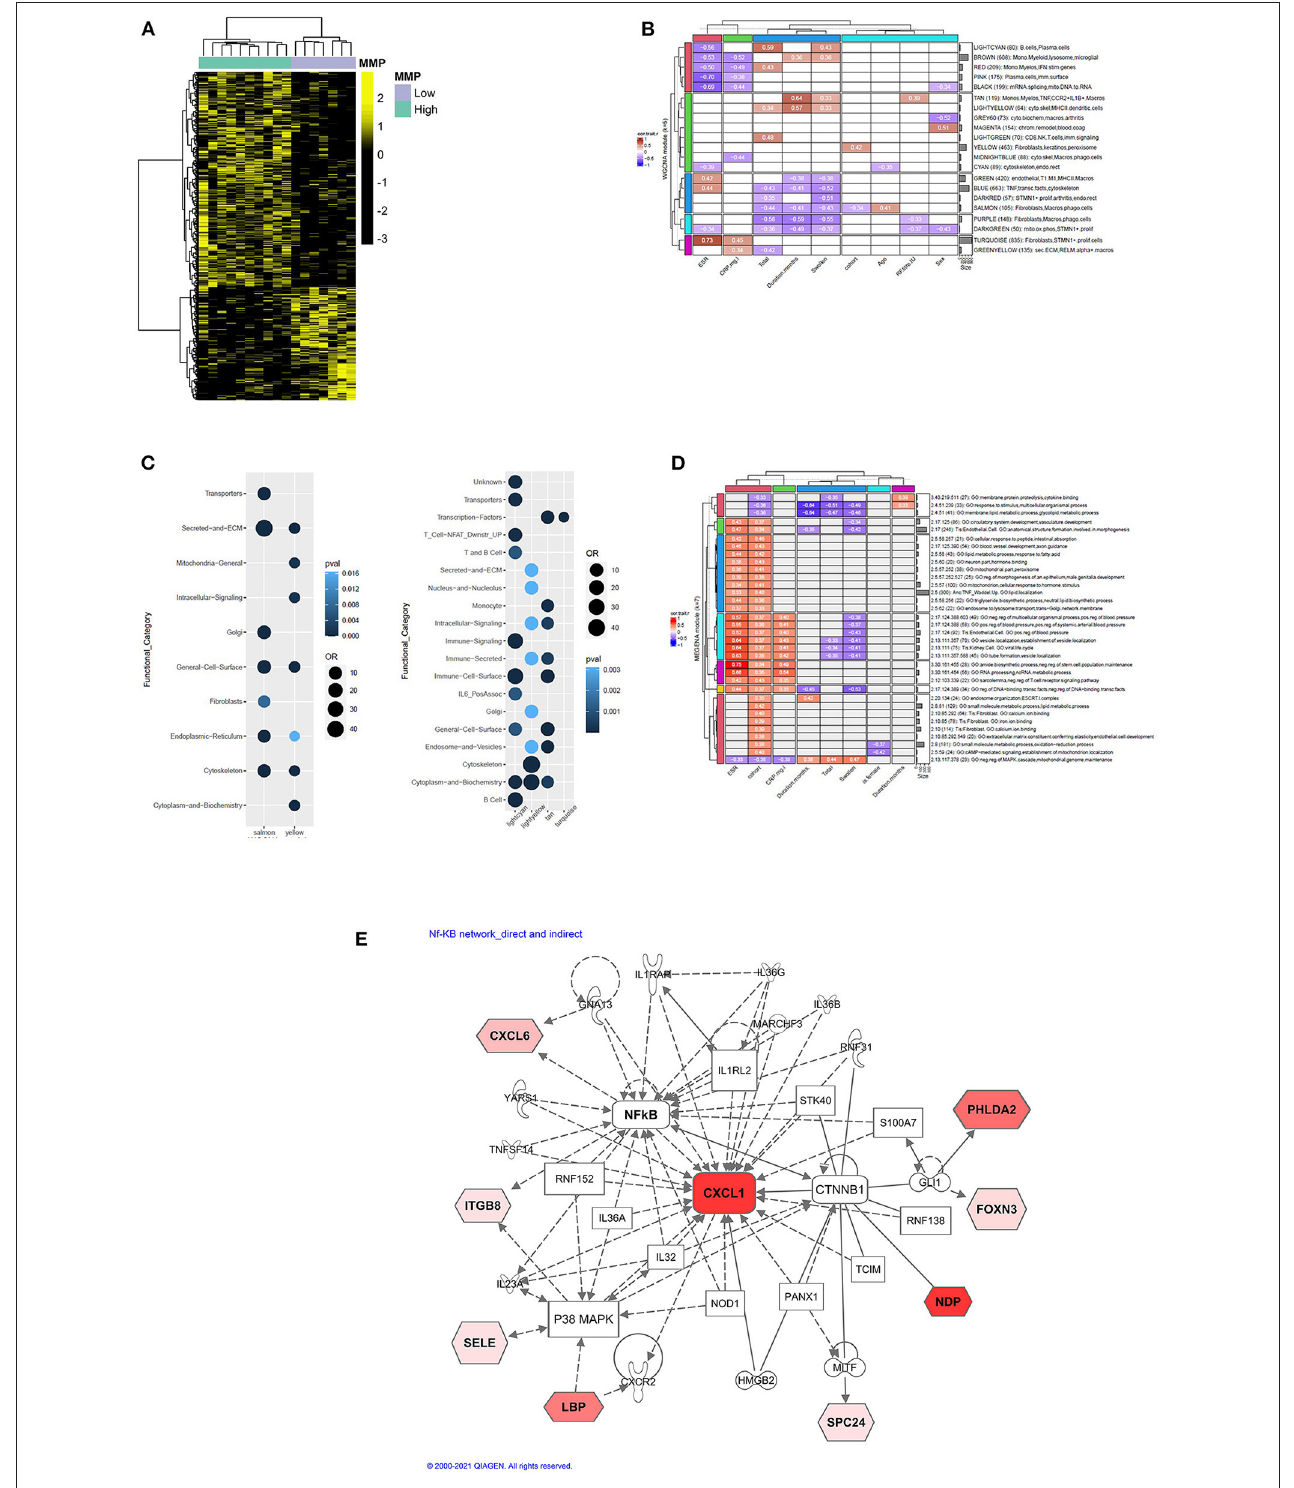
FIGURE 3 | (A) Heatmap showing unsupervised hierarchical clustering of differentially expressed genes (DEGs) between MMP-high and MMP-low groups. Genes were clustered using Pearson correlation and complete linkage clustering algorithms. (B) Hierarchical clustering plot showing 21/23 WGCNA modules with significant correlations to at least one clinical trait of the 17 EIA samples. Pearson correlation coefficients are colored according to the legend and values overlaid in their respective cells. (C) Pearson correlation plots showing interactions between WGCNA modules and functional pathways. (D) Hierarchical clustering plot showing Pearson correlation between MEGENA modules and clinical variables. (E) Ingenuity pathway analysis (IPA) showing curated molecular interactions between DEGs in MMP-high cohort. Molecules highlighted in red (or shades of red) represent DEG that are elevated in MMP-high cohort.